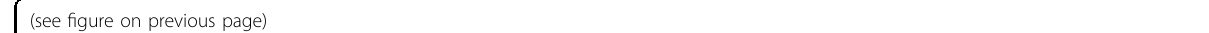
Fig. 3 Classi fi er development, performance testing, and validation in independent blinded datasets. a Schematic work fl ow of the classi fi er development. Protein features were prioritized based on the discovery dataset. The model was trained using 19 proteins selected from the discovery dataset and further validated in test datasets. More details are described in Materials and Methods. b The importance rank of the selected 19 protein features was interpreted by SHapley Additive exPlanations (SHAP) algorithm. c Protein abundance distribution of the 19 features. d Network of the 19 proteins. Blue nodes and orange nodes indicate the protein features and connected molecules or pathways, respectively. Direct interactions are in solid lines and indirect interactions are in dash lines. e ROC plots of seven different machine learning models of 19 selected features. f ROC plots of the discovery set, retrospective test sets, prospective test sets and Bethesda III and IV samples in the prospective test sets. g UMAP plots showing the separation between benign and malignant groups in the retrospective and prospective test sets using 19 protein features with latent space. h Overall performance metrics of prediction of the neural network model for fi ve speci fi c histopathological types per set. Graduated colors in the shaded bar indicate accuracy levels. Numbers in the boxes indicate the number of correctly identi fi ed samples/total sample number. HCA and HCC were assigned as FA and FTC, respectively. i Sankey diagram showing the distribution ratio and correspondence between histopathology and cytopathology in the prospective sets. Histopathological type L denotes lymphocytic thyroiditis. Cytopathology scores were assigned by specialized pathologists using the Bethesda System. TP, TN, FP, and FN indicate true positive, true negative, false positive, and false negative, respectively, of the results predicted by our classi fi er